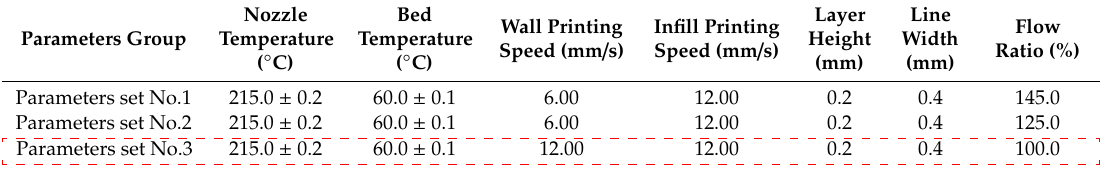
Table 3. Technological tests of 3D printing parameters (red dotted line—selected group of 3D printing parameters).